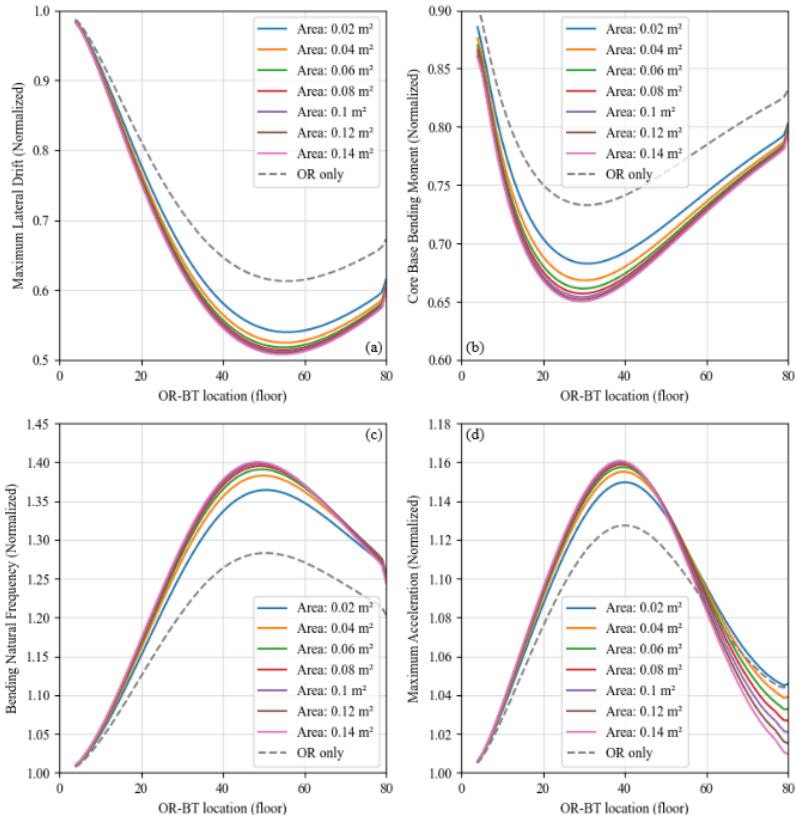
Figure 7. Influence of the BT area in relation to the optimum location to (a) MLD (b) CBM (c) Bending. natural freq. (d) Max.